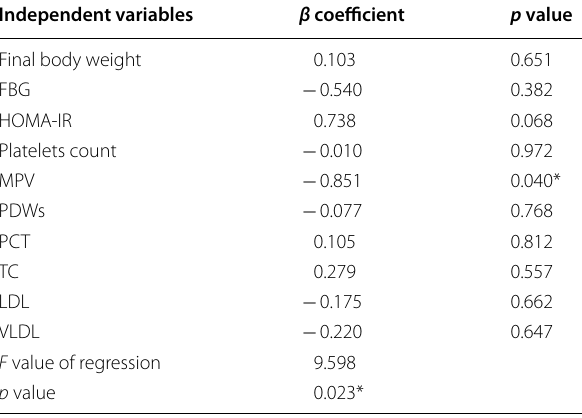
Table 4 Multiple linear regressions of sRAGE with the dependent variable